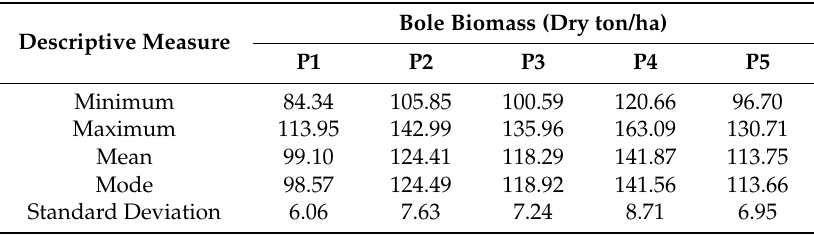
Table 1. Descriptive measures of the values of eucalyptus bole (m 3 /ha) 36 months after the implementation of the financial investment